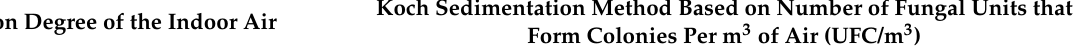
Table 2. Assessment of the degree of air contamination in a room, according to the sanitary norms applied to non-industrial institutions